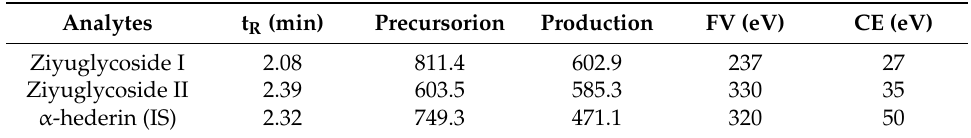
energy (CE) for each